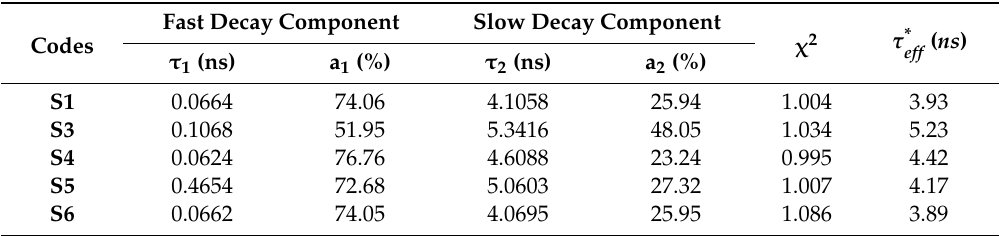
Fitted decay times and average lifetimes ( τ ∗ ZnO:MoO 3